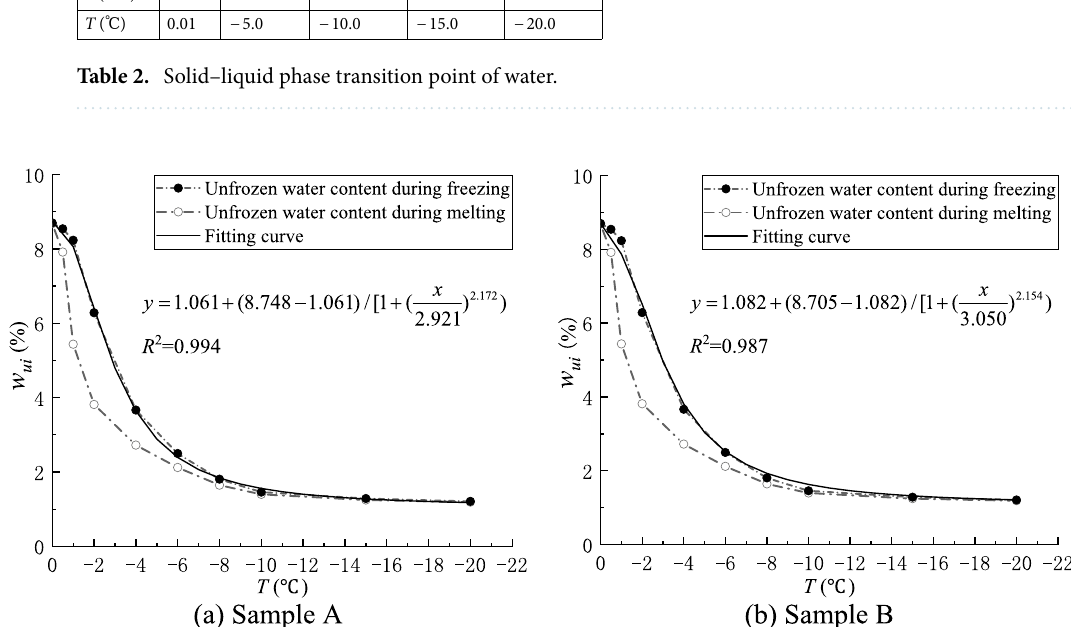
Figure 5. Relationship between unfrozen water content and temperature during coal sample